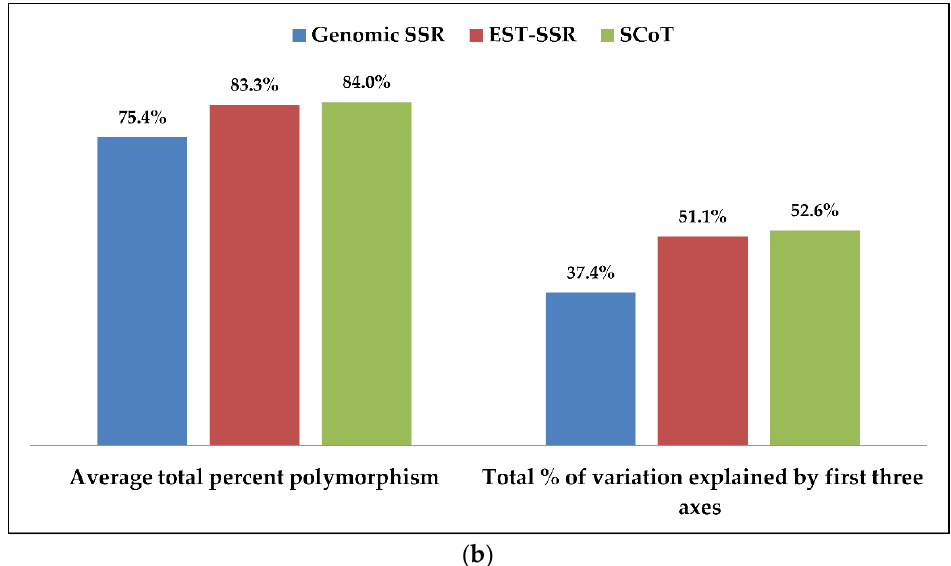
Figure 5. ( a ) Comparison of g-SSR, EST-SSR, and SCoT markers on diversity parameters of 28 Tinospora accessions. ( b ) Comparison of percent polymorphism between g-SSR, EST-SSR, and SCoT markers of 28 Tinospora accessions.